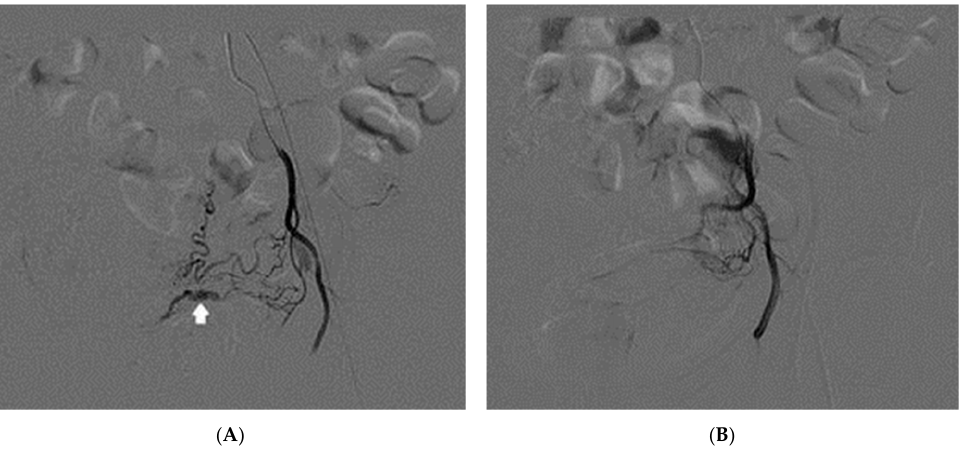
Figure 3. ( A ) Selective angiography of the left internal iliac artery before embolization: the contrast media injection shows an abnormal dilatation with contrast media extravasation (indicated by the arrow) out of the distal branch of the left uterine artery. ( B ) Angiography after embolization with embolic particles; the lesion is no longer visible.